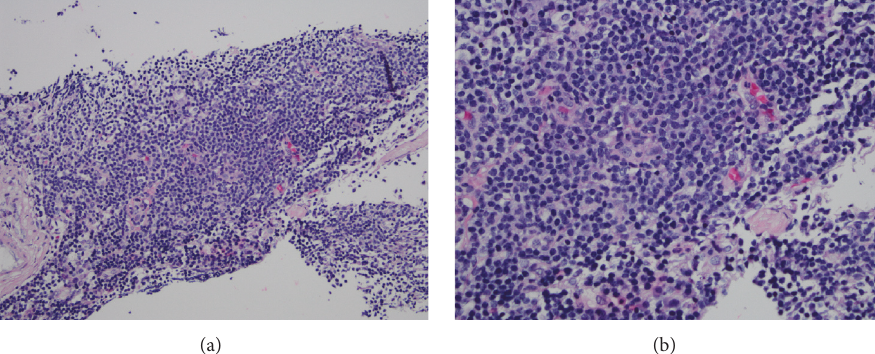
Figure 3: (a) 200x: left axillary monotonous population of small lymphocytes with mature nuclear chromatin and distinct rims of cytoplasm. (b) 400x: left axillary monotonous population of small lymphocytes with mature nuclear chromatin and distinct rims of